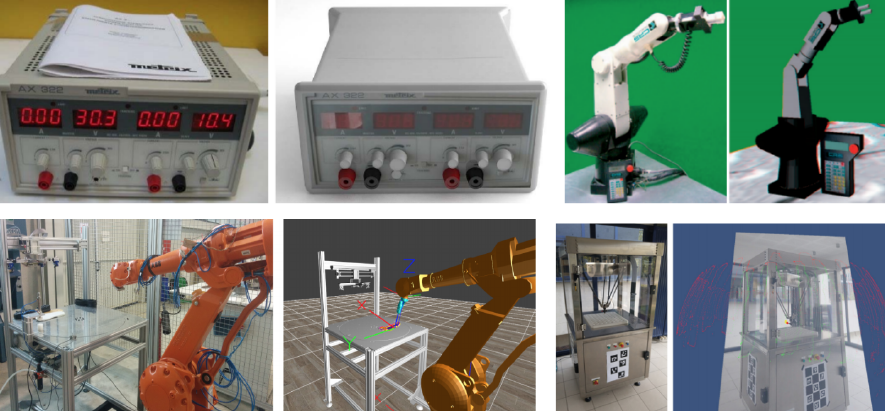
Figure 3. Real engineering labs and its representation in VR. From left: power block [78], CRS robotic arm [79], robotic cell for shoe-sole gluing [80] and industrial picking robot